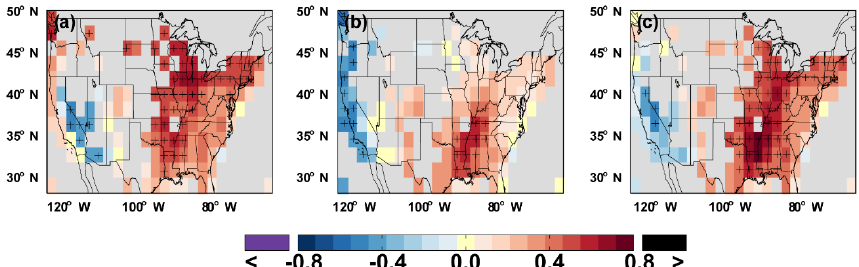
Figure 8. Correlation for interannual variability over 1990–2010 between the annual AMO (a) , ONI (b) , and AMONI (c) anomalies and the annual average daily mean 2m air temperature from MERRA. Correlations are statistically significant ( P value<0.05 after a one-sided t test) in grid cells overlaid with + . MERRA temperature data are available through 2010 and are sampled based on valid daily mean ozone data. MERRA data are used here (in place of GEOS-5) to include years prior to 2004. All data are detrended prior to correlation calculations. The grid cells in grey have no AQS data.